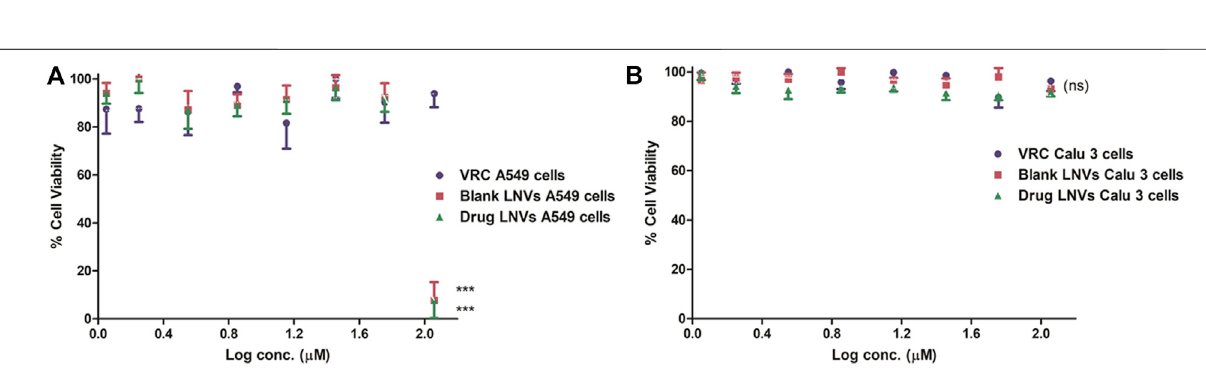
Frontiers in Pharmacology |